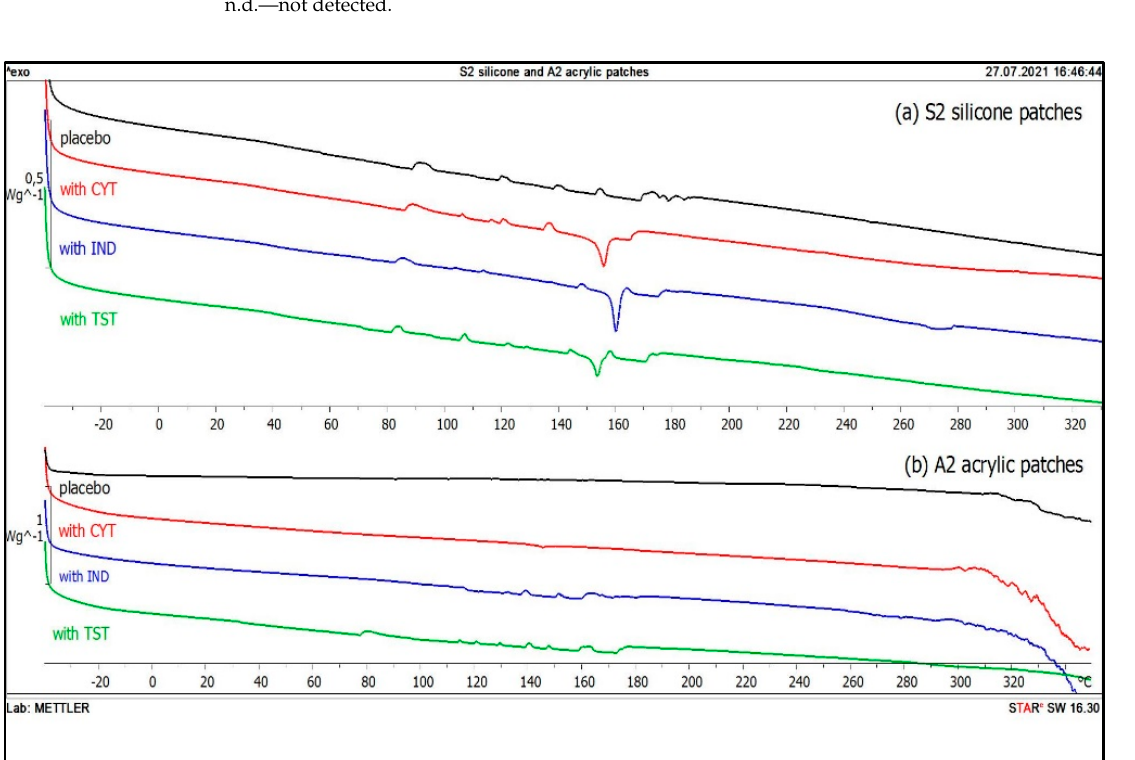
Figure 7. DSC thermograms of S2 silicone patches ( a ) and A2 acrylic patches ( b ): placebo (black), with CYT (red), IND (blue), TST (green).